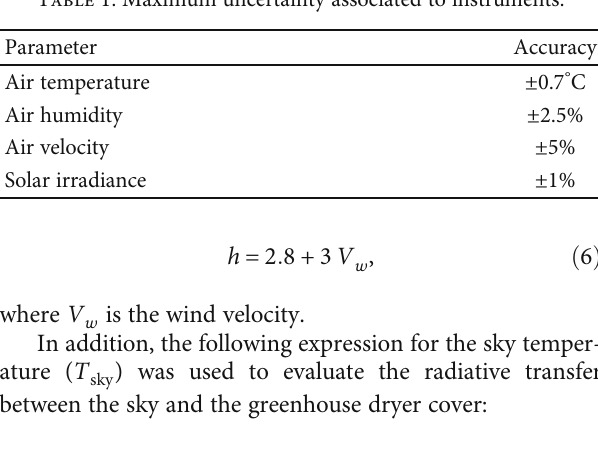
Table 1: Maximum uncertainty associated to